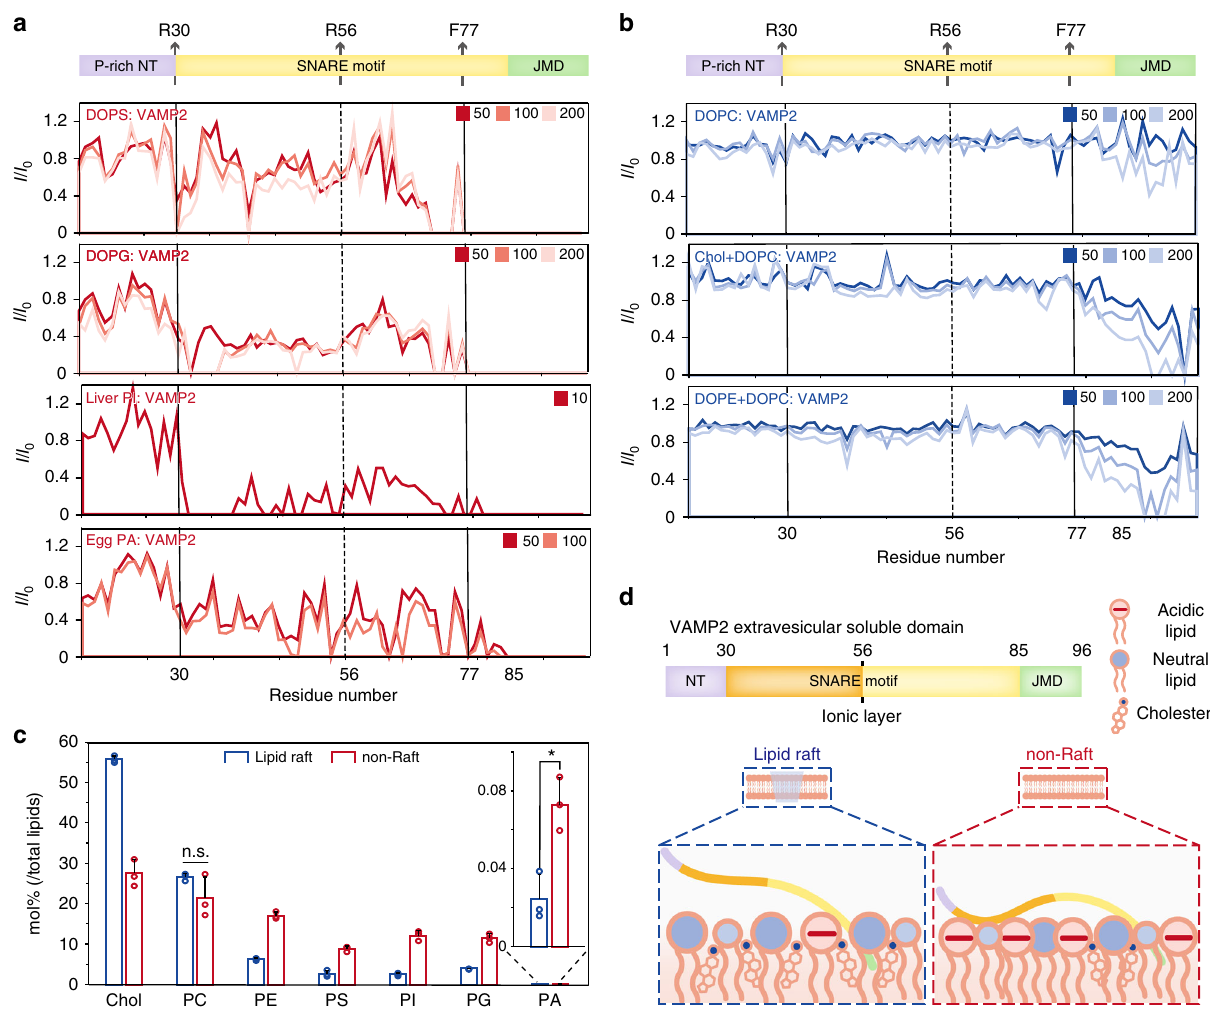
Fig. 4 VAMP2 SNARE motif sensors the electrostatic property of membrane surface. a Residue-resolved NMR signal intensity ratios ( I / I 0 ) of VAMP2 (1 – 96) titrated by acidic liposomes (DOPS, DOPG, liver PI, and egg PA) to that in solution at indicated lipid/protein molar ratios. b Residue-resolved NMR signal intensity ratios ( I / I 0 ) of VAMP2(1 – 96) titrated by neutral liposomes (DOPC, cholesterol/DOPC (1/1, mol/mol) and DOPE/DOPC (1/1, mol/mol)) to that in solution at indicated lipid/protein molar ratios. c Comparisons of individual lipid classes in lipid-raft and non-raft SV. Error bars are standard deviations from three biological replicates. The data were analyzed by Student ’ s t -test. The p -values of all lipid subclasses, except for PC and PA, are less than 0.001. n.s. represents not signi fi cant. * indicates p -value < 0.05. d Schematic presentation of VAMP2 extravesicular domain on lipid-raft and non-raft membranes. Source data are provided as a Source Data